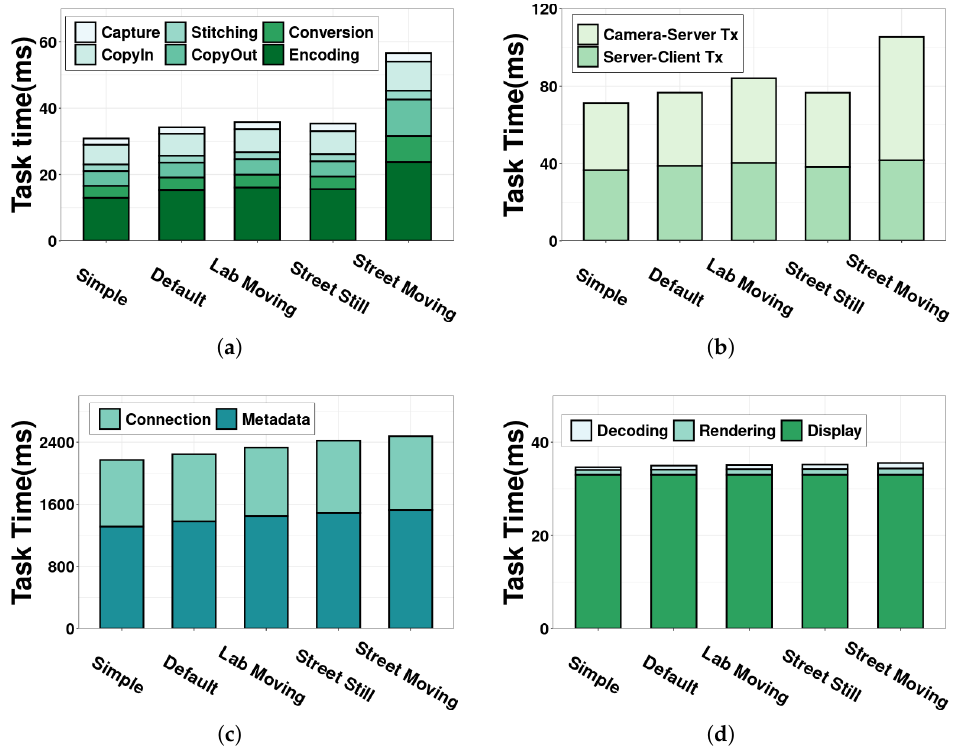
Figure 19. The task-level time breakdown under five usage scenarios for all system components. ( a ) 360° camera; ( b ) CST and SCT; ( c ) Video server; ( d ) 360° video